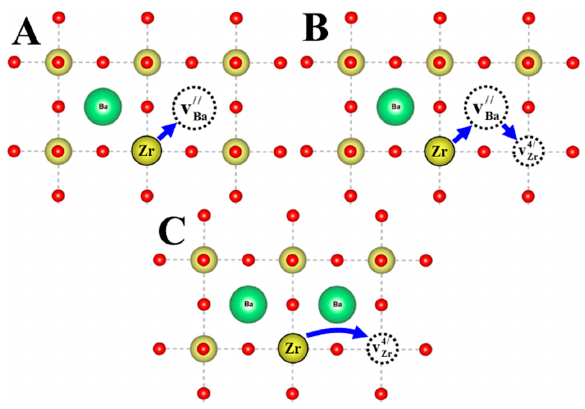
Figure 5. A schematic of diffusion pathways for Zr 4+ cations in non-stoichiometric BaZrO 3 : ( A ) via Ba-vacancy; ( B ) via both Ba- and Zr-vacancies; ( C ) via Zr-vacancy. Zr yellow, Ba green, O red. Relaxation of the crystal structure around the vacancies are not included in the illustration for simplicity.